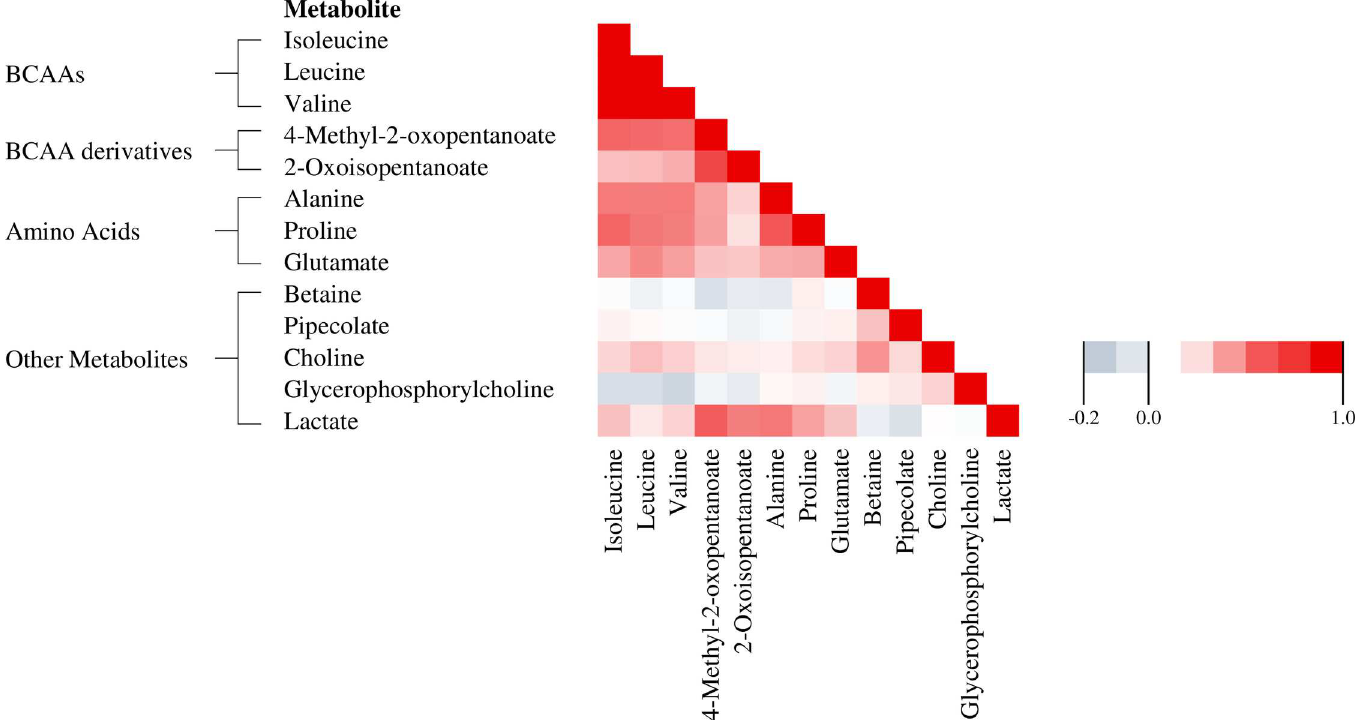
Fig 1. Correlation matrix for plasma metabolite levels: Pearson correlation coefficients for 13 metabolite concentrations (log-transferred) associated with TPA in the original dataset.